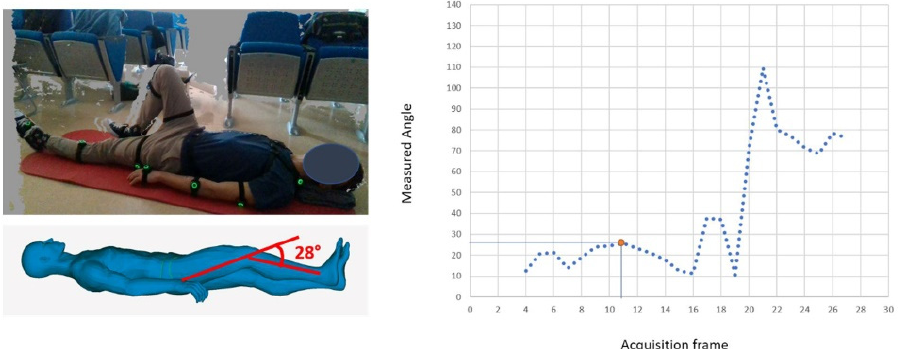
Figure 12. Comparison between the CAD-based measurement on the 3D avatar (ground truth) and the automatic measurement in case of isometric quadriceps contraction of the right knee.